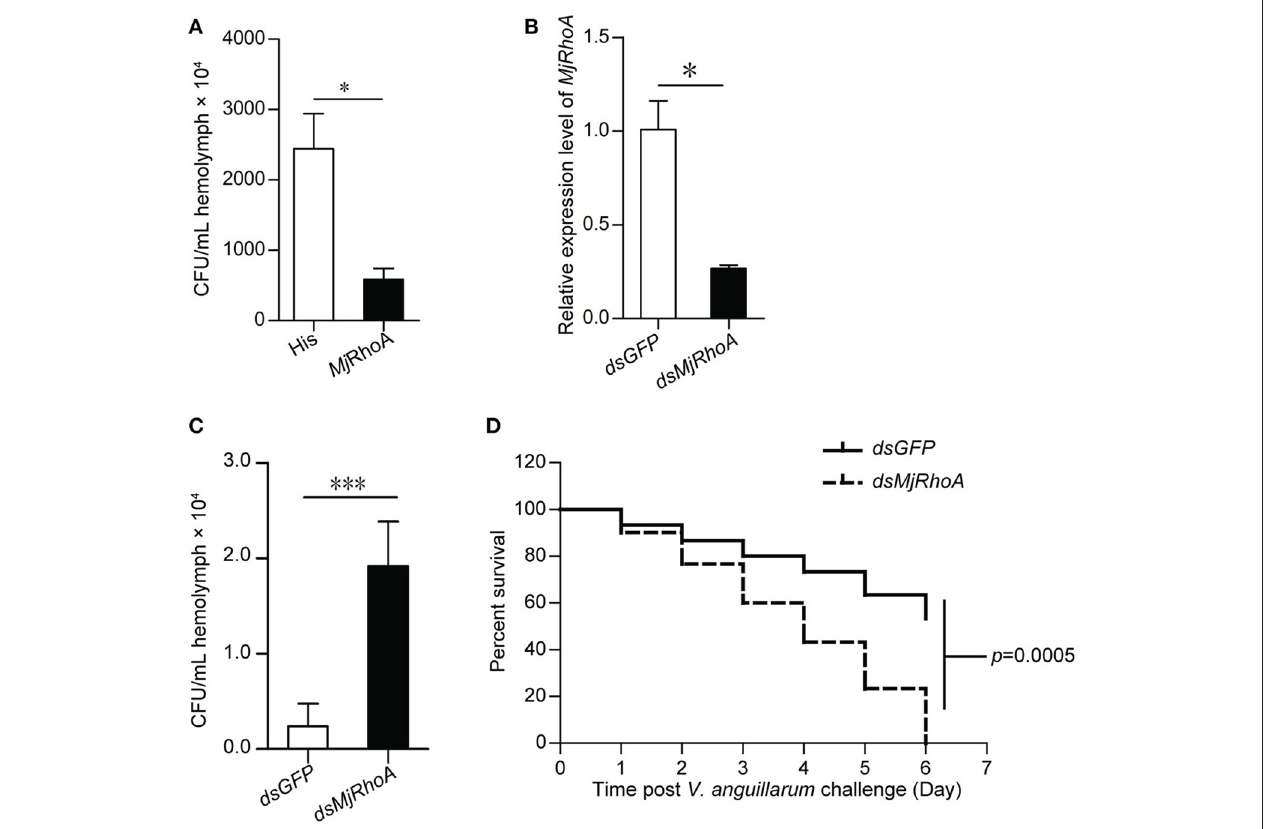
FIGURE 2 | The total bacteria number and survival rate analysis after overexpression and knockdown of Mj RhoA. (A) Total bacteria detected after treatment with Mj RhoA (“overexpression”) in the shrimp infected with V. anguillarum . After overexpression of Mj RhoA, the total bacteria from the whole hemolymph were counted. The bacteria number in the His-tag injection group was used as a control. (B) The efficiency of MjRhoA RNAi. Shrimp were injected with 30 µ g of dsMjRhoA and the same amount of dsGFP , respectively. After 48h, the shrimp hemocytes were collected and the total RNA was extracted for qPCR analysis. Shrimp injected with dsGFP were used as a control. (C) Total bacteria in vivo detecting after knockdown of MjRhoA . The whole hemolymph of shrimp were collected and spread onto the LB solid medium. After growing at room temperature, the total bacteria were counted. The total bacteria number in the dsGFP injected shrimp was used as a control.